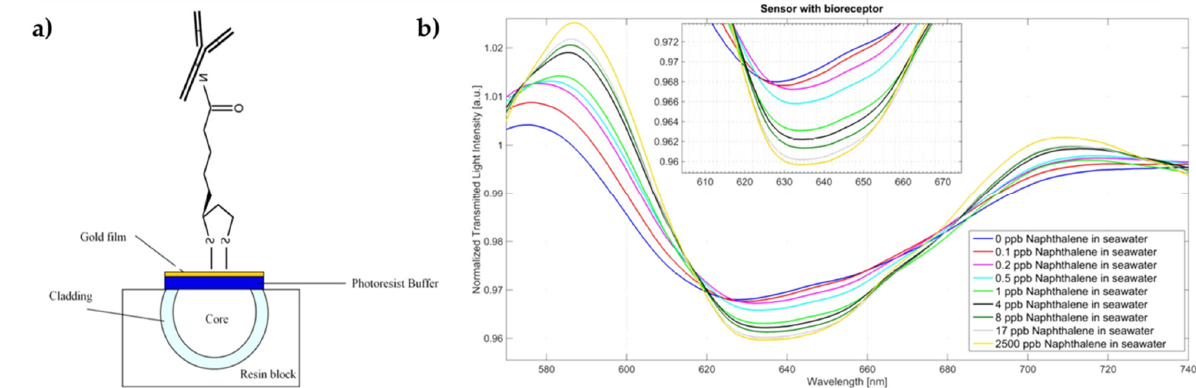
Figure 17. ( a ) Representation of the SPR-based D-shaped POF sensor for specific detection of naphthalene; the Au thin layer was modified with α-lipoic acid and then the anti-naphthalene antibodies were covalently linked via EDC/NHS chemistry; ( b ) normalized transmitted spectra in the wavelength range of the SPR showing its variations as a response to the naphthalene concentration. Reprinted with permission from ref. [56]. Copyright 2019